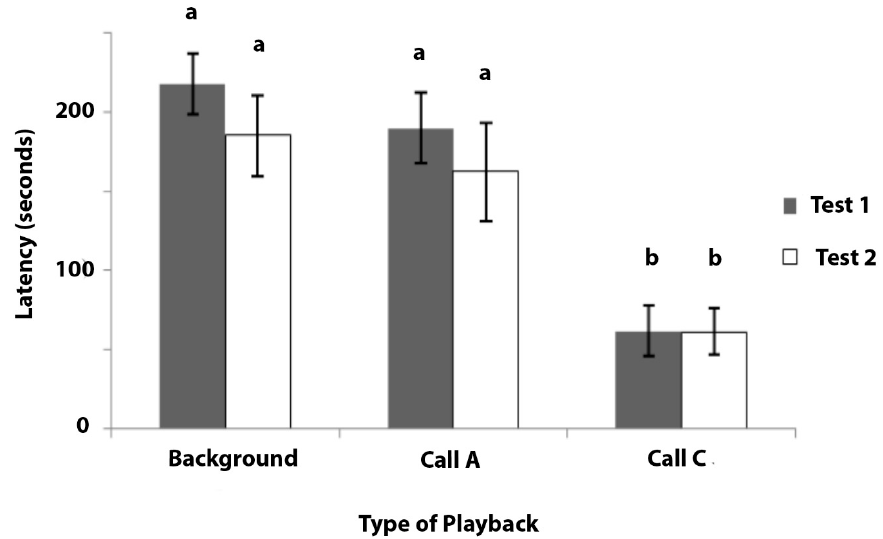
Figure 6. Experiment 4. Mean latency in seconds from the commencement of the playback to the first inspection of the cup (for mealworms) is plotted with standard errors indicated. The playbacks were background noise that was recorded in the animal house, Call A, and Call C. Bars marked ( a ) are significantly different from those marked ( b ). N = 7. Maximum response latency was 240